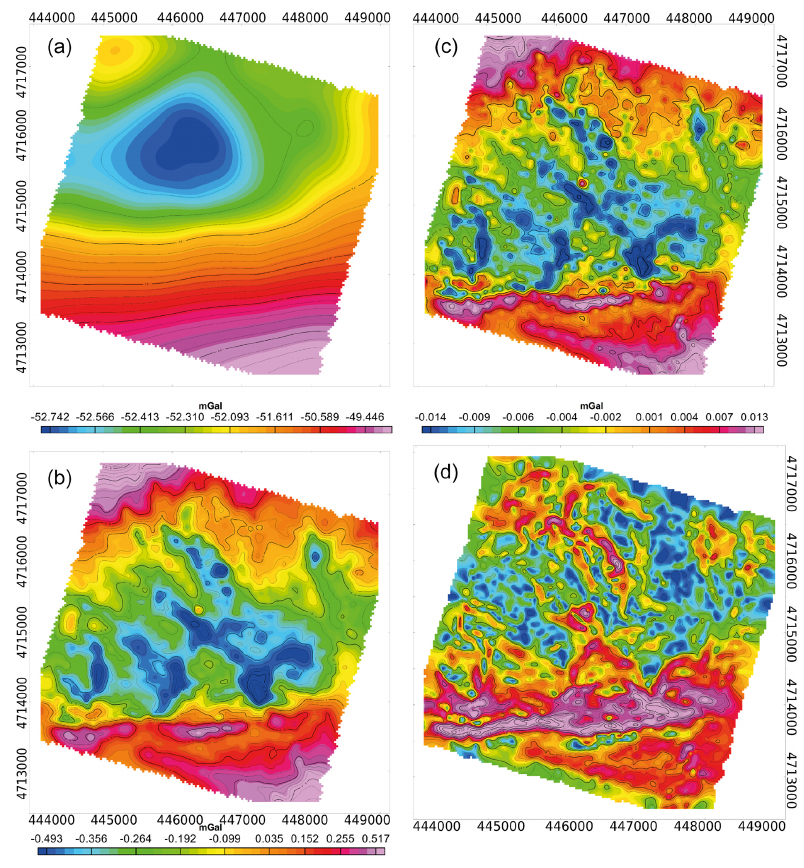
Figure 4. (a) Regional gravity anomaly of the study area obtained by upward continuation up to 350m, (b) resulting residual anomaly, (c) first vertical derivative of the Bouguer anomaly (BA) map (order 0.75), (d) total horizontal derivative (THD) of the BA map.